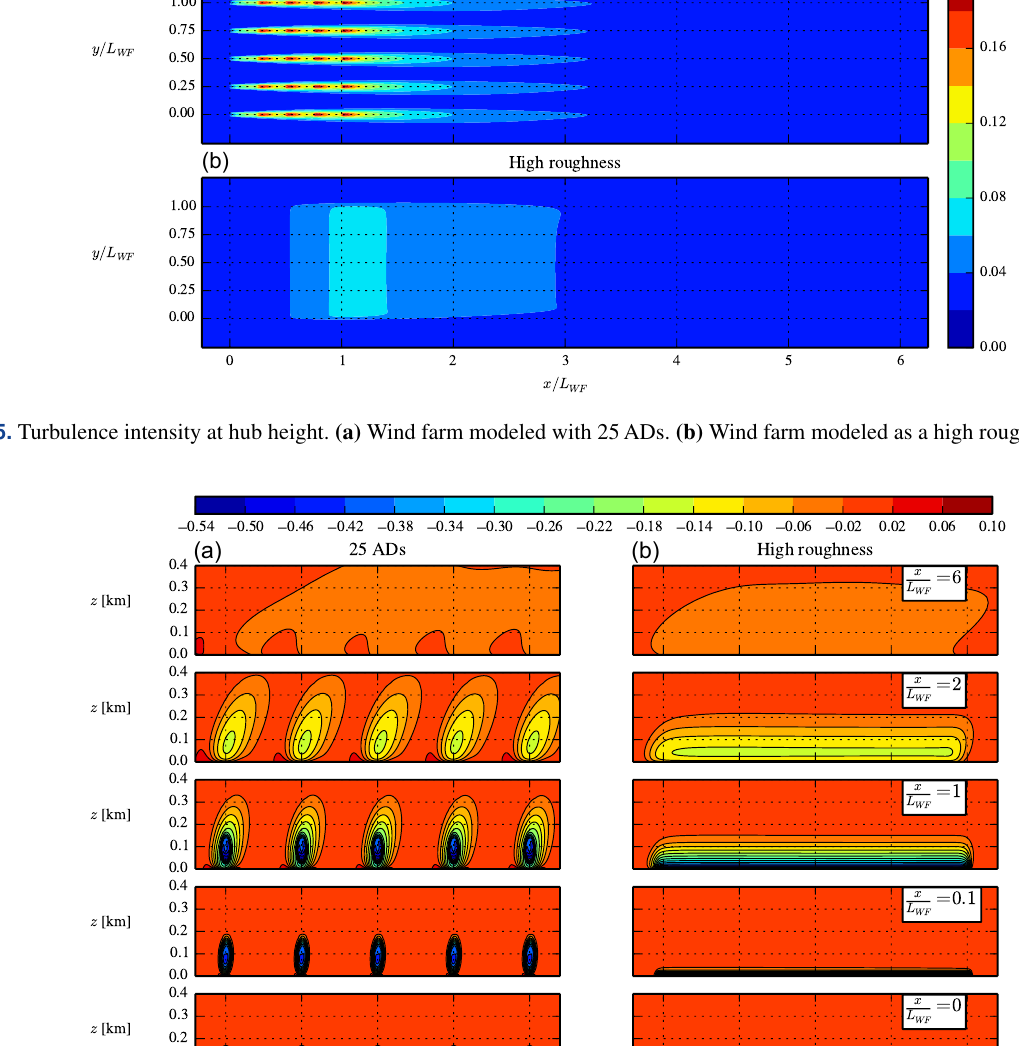
The top and bottom figures show results from the